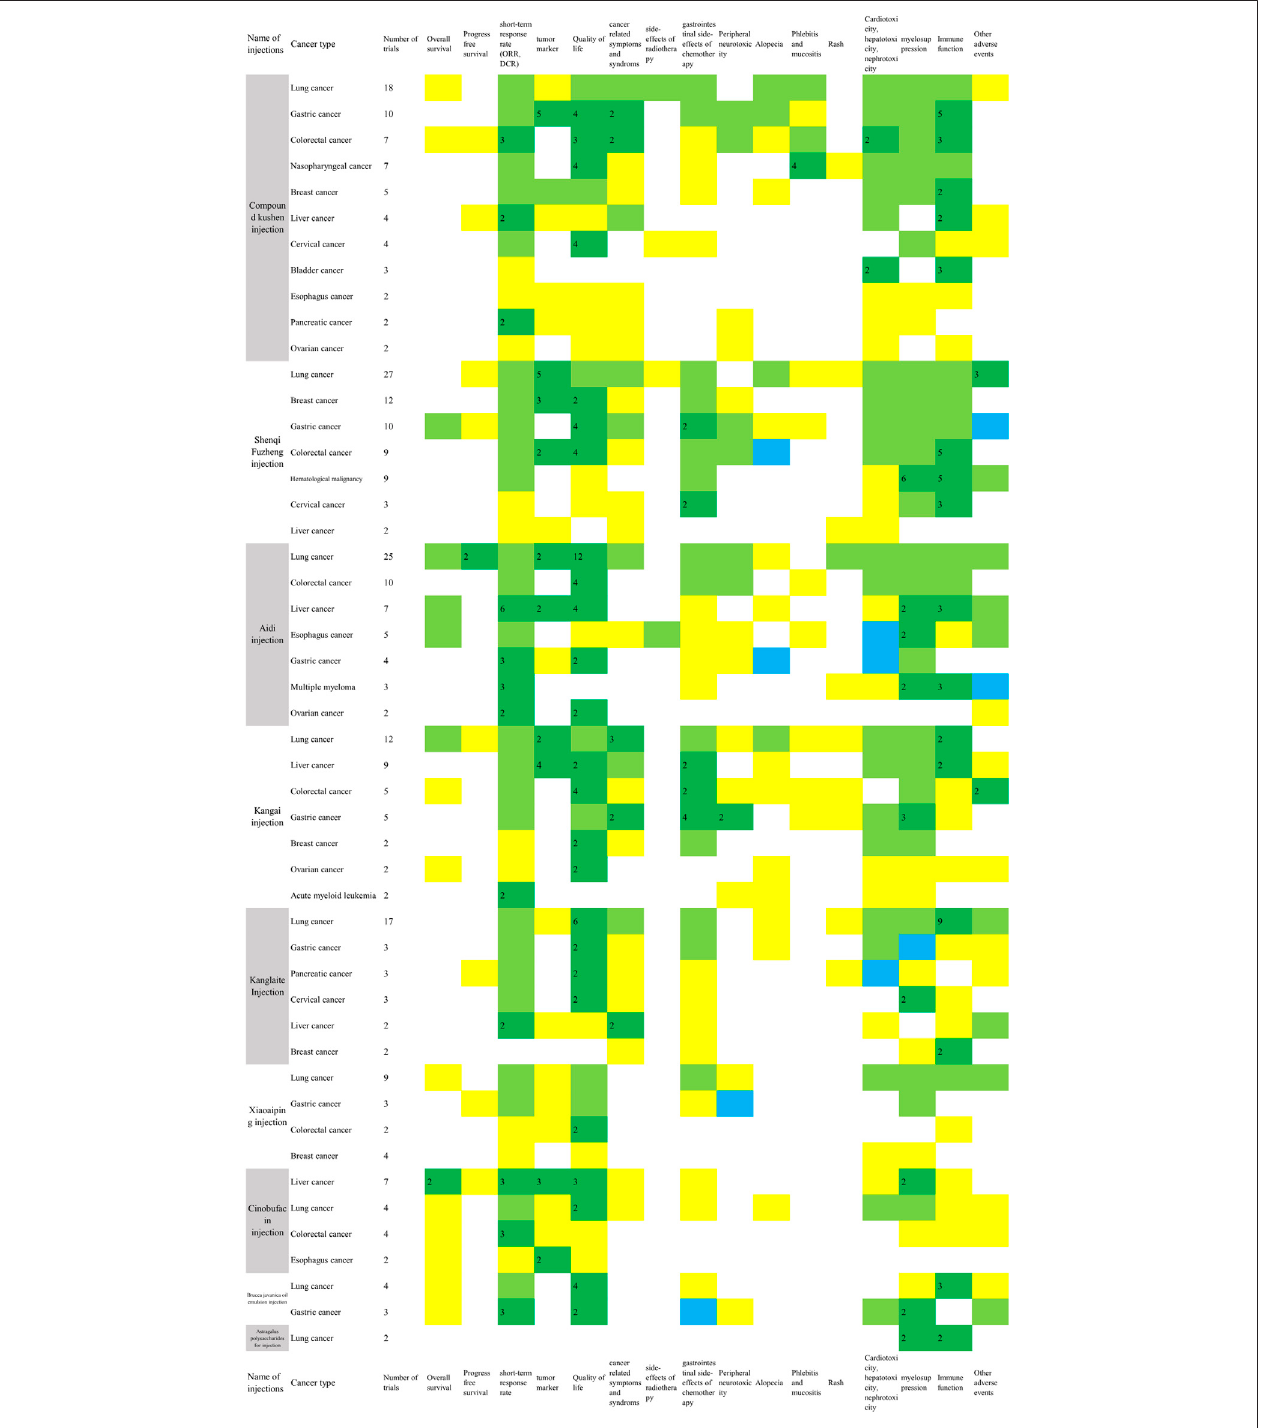
FIGURE4| Evidence mappingofthereported clinicaloutcomes bycancertypes (Twoor moreRCTs forasingle cancertype wereshown in Figure 4 .Darkgreen: at least two trials showed consistent bene fi cial effect for all measurements on summarized outcome with no signi fi cant or harmful effects; Light green: some of the reported outcomes showed bene fi cial effect and some did not show signi fi cant effect; Yellow: a single study reported the outcome in spite of the direction of the effect. Blue: all of the reported outcomes showed no signi fi cant effects; Red: any study showed harmful effects. The number in dark green cells presented the number of RCTs. ORR, objective response rate; DCR, disease control rate; Quality of life includes KPS scores, ECOG scores and other scales for quality of life; Cancer related symptoms include fatigue, cancer pain, cancer fever and decrease of weight; Side-effects of radiotherapy include radiation pneumonitis, radiation esophagitis and radiation enteritis; Gastrointestinal side-effects of chemotherapy include nausea and vomiting, diarrhea, and constipation; myelosuppression includes leukopenia, neutropenia, thrombocytopenia, anemia, and erythrocytopenia; Immune function includes CD3, CD4, CD4/CD8, and NK cell level.).